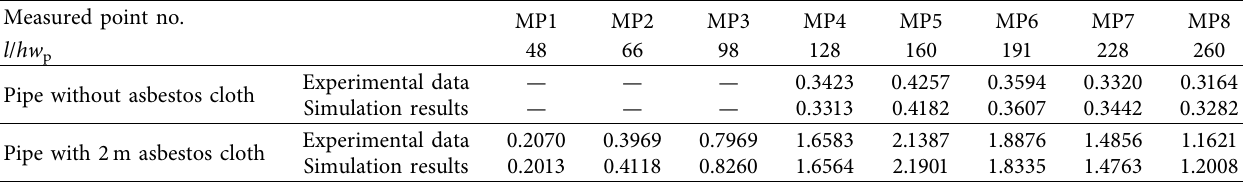
Table 3: Explosion wave peak pressures in long pipe (1.01 × 10 5